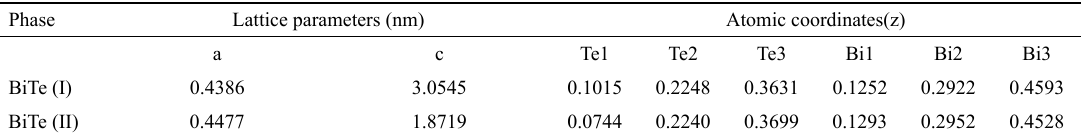
Table 1. Structural information of BiTe (I) and BiTe (II) developed after 15 min of milling.